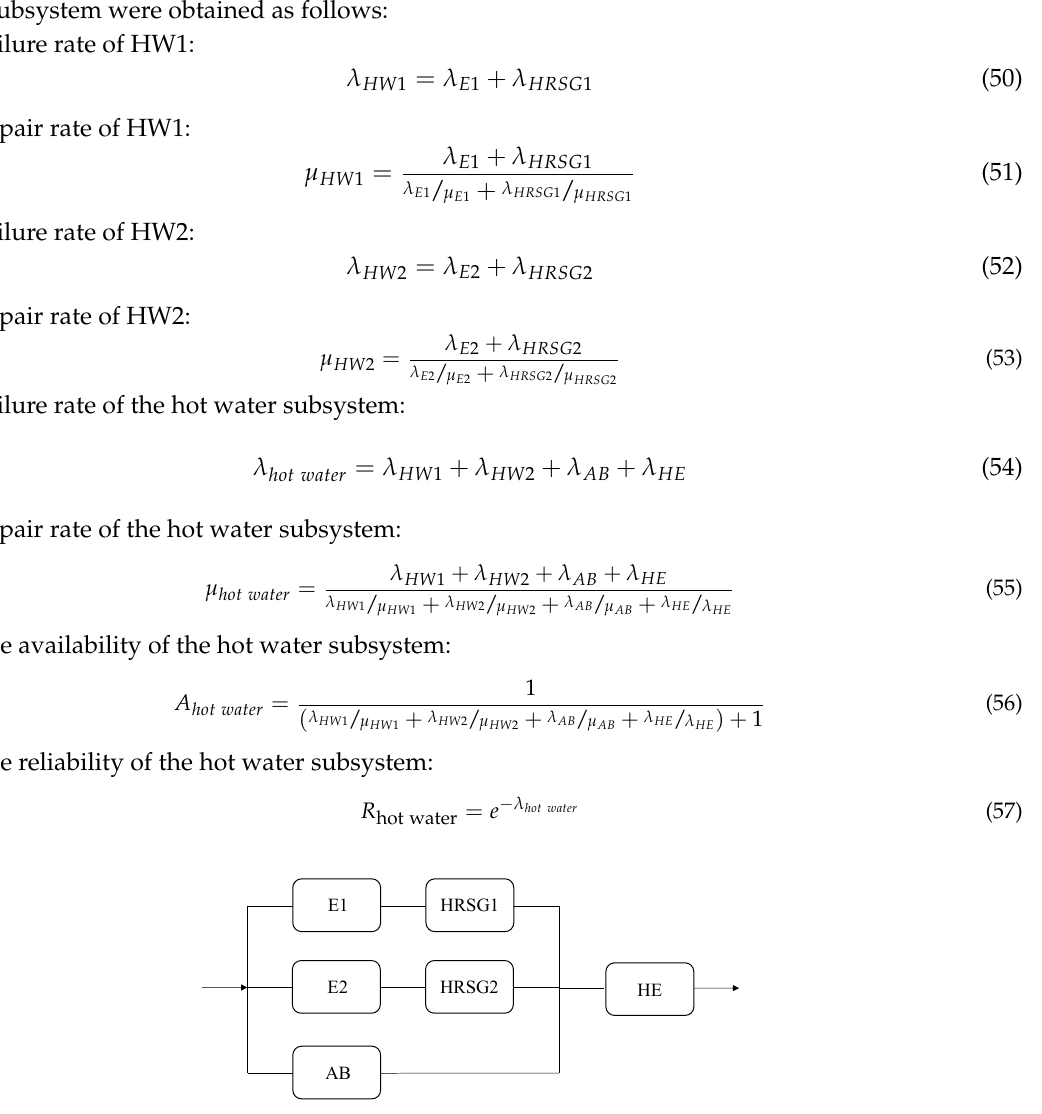
Figure 7. The reliability block diagram of the hot water subsystem of the CCHP system. Table 10. The operation states and reliability data for the hot water subsystem of the CCHP system.